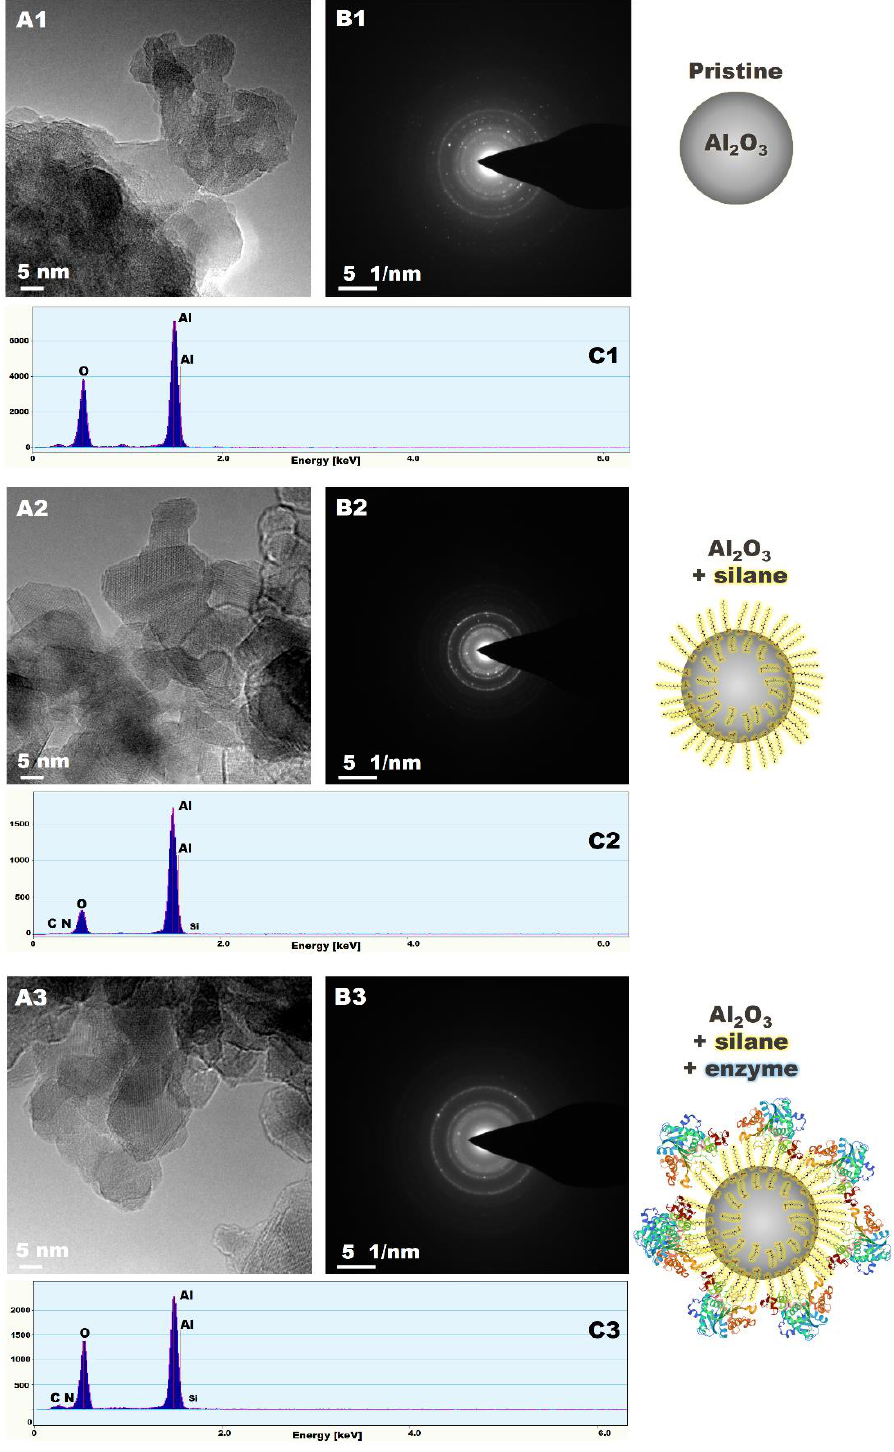
Figure 3. HR – TEM: bright field ( A 1, A 2, A 3), SEAD images ( B 1, B 2, B 3), and EDX spectra ( C 1, C 2, C 3). A 1, B 1, C 1: pristine Al 2 O 3 ; A 2, B 2, C 2: Al 2 O 3 functionalized with silane; A 3, B 3, C 3: Al 2 O 3 func- ( A1 – C1 ): pristine Al 2 O 3 ; ( A2 – C2 ): Al 2 O 3 functionalized with silane; ( A3 – C3 ): Al 2 O 3 functional- ized with silane and